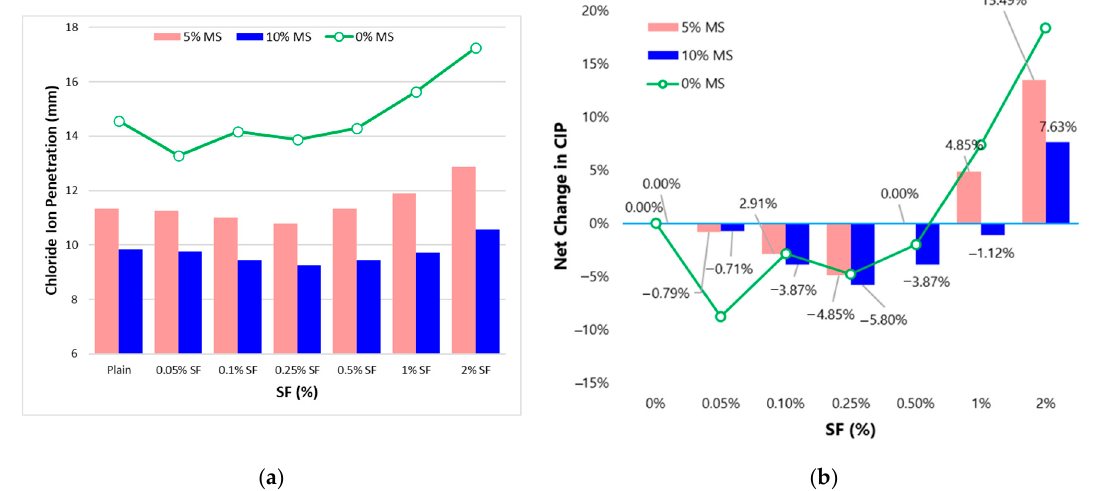
Figure 14. Chloride-ion penetration (CIP) results ( a ) effect of MS on CIP with varying SF dosage ( b ) effect of MS on the net change in CIP with varying SF dosage.